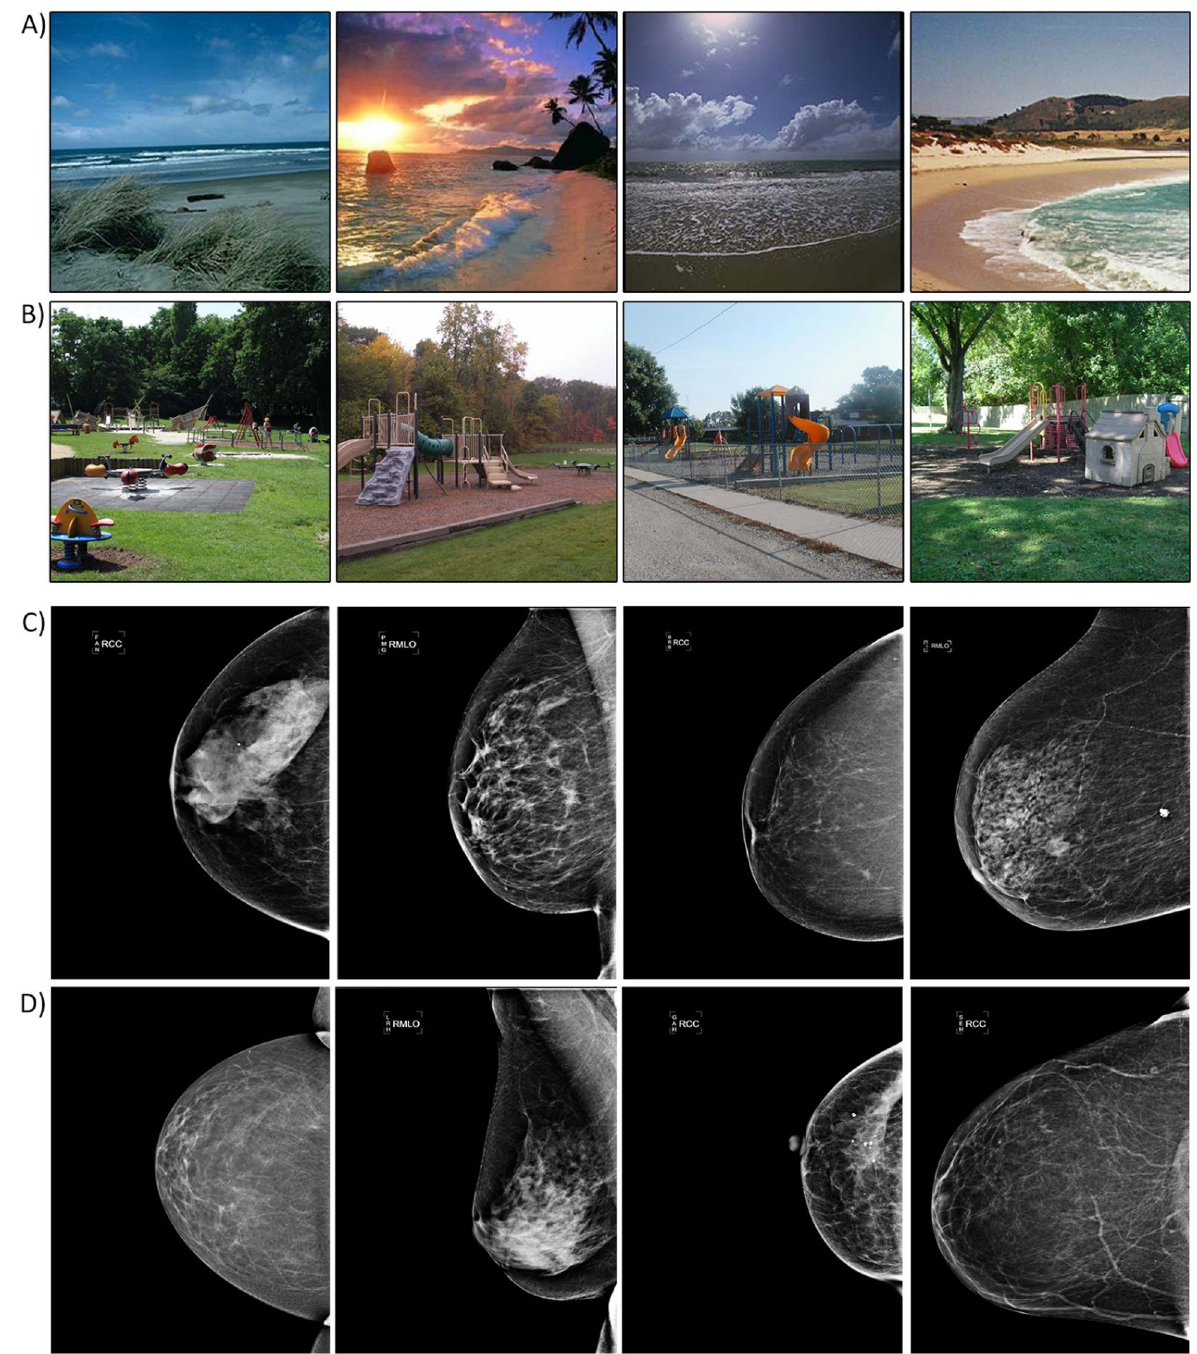
Fig. 1 Scene exemplars for beaches ( A ) and playgrounds ( B ) that illustrate the variation in viewing angle, lightning, configuration, and specific objects. Mammogram exemplars containing subtle abnormalities ( C ) or no abnormalities ( D ) illustrating the variation in shape, size, and textural